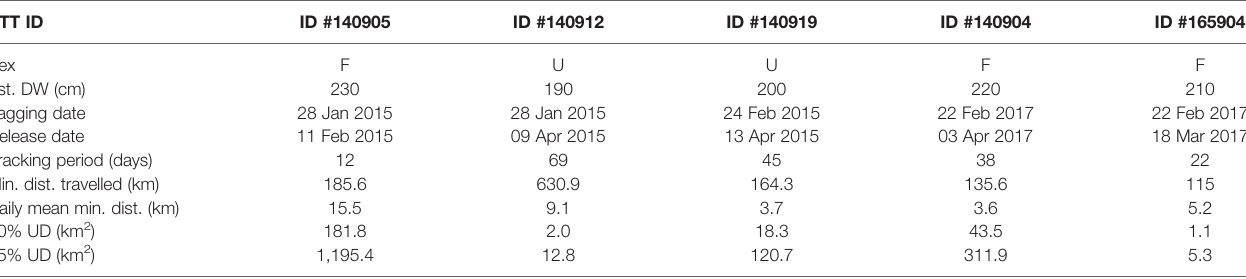
TABLE 1 | Summary details for juvenile M. alfredi satellite tracked in Wayag lagoon in 2015 and 2017. PTT ID